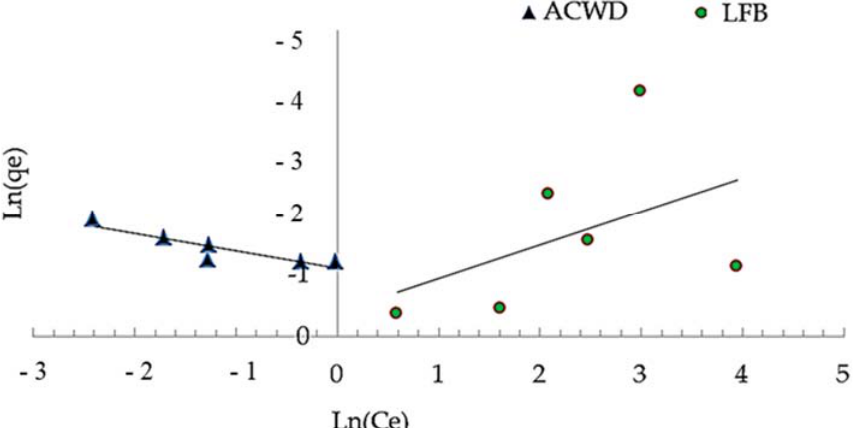
Figure 9. Langmuir isotherm plot for the sorption of ammonia using whole biomass (ACDW) and lipid ‐ free biomass (LFB) of Arthrospira platensis.